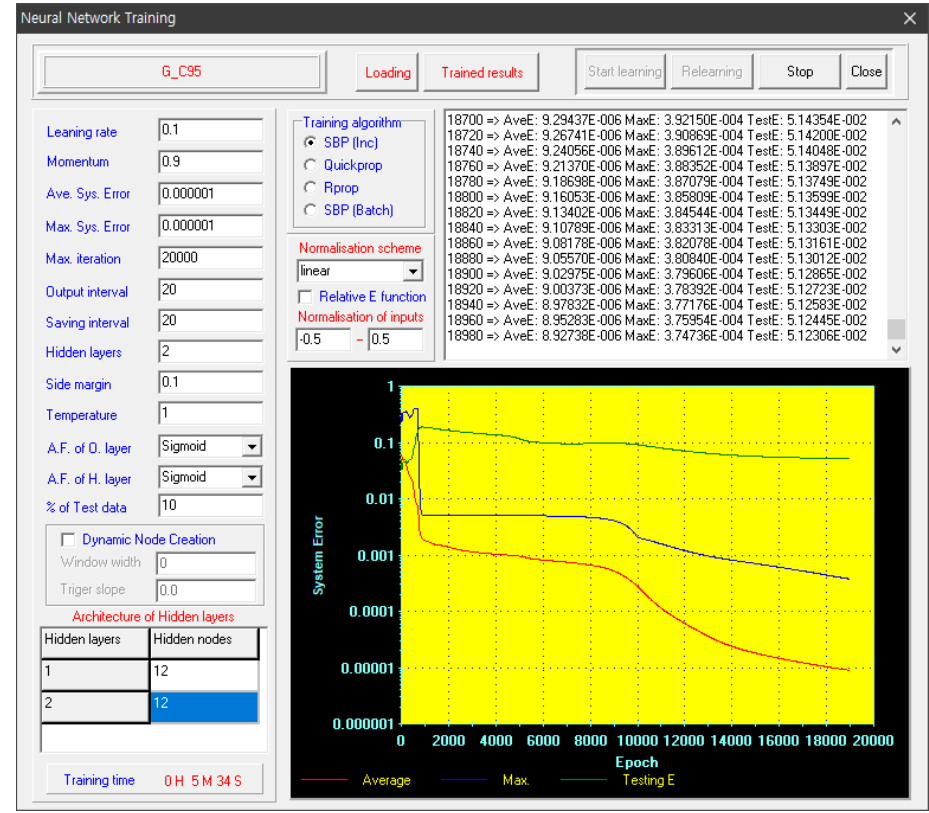
Figure 4. An example of GDAP training.